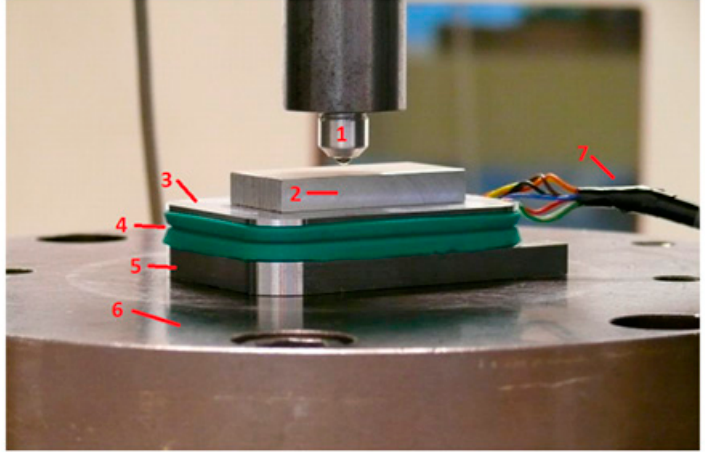
Figure 3. Validation of the sensor in the static situation using a bench press. The sensor (3–5) was placed between a solid underground (6) and a solid plate (2) to increase the area of applied force by the bench press (1). Incremental forces from 0 to 1000 N were applied to the sensor. For this experimental set-up a cable (7) was connected from the sensor to a laptop to analyze the data in the static situation.